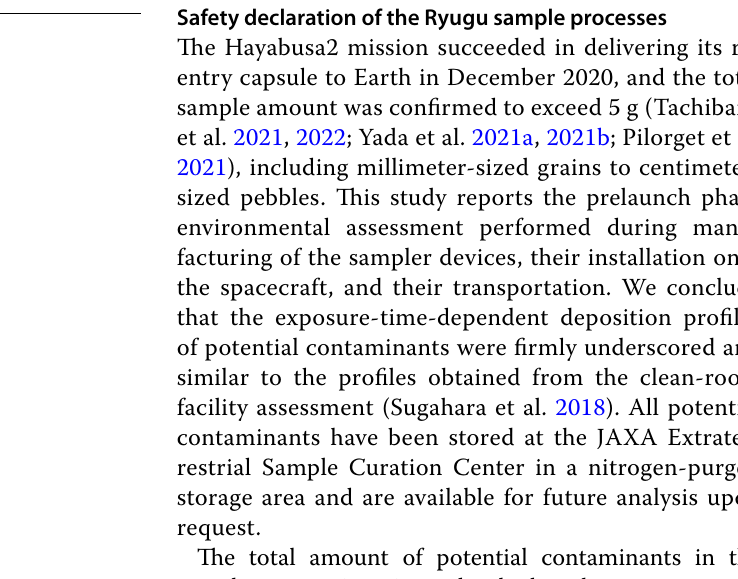
Table 5 Basic principal component statistics in the static samples (i.e., CPS1–12 and CAS1–12; n Concentration (ng/